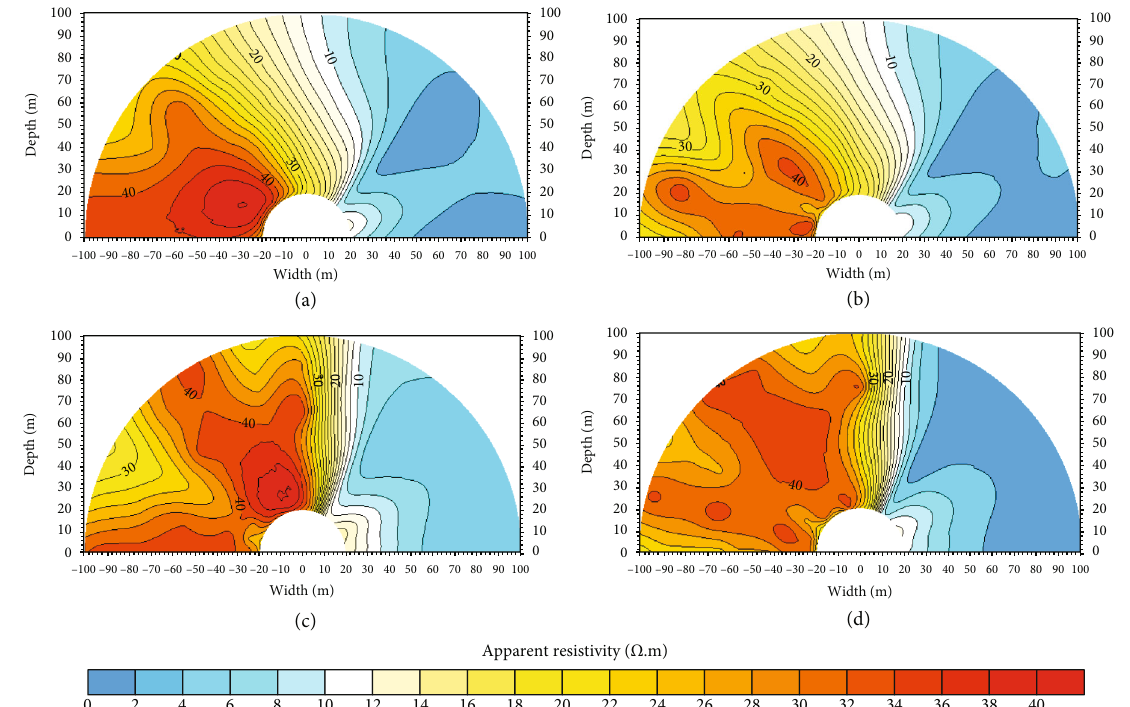
Figure 13: Resistivity characteristics of water-bearing goaf in the mine TEM. (a) Seam roof 30 ° . (b) Seam roof 15 ° . (c) Seam fl oor 15 ° . (d) Seam fl oor 30 ° .